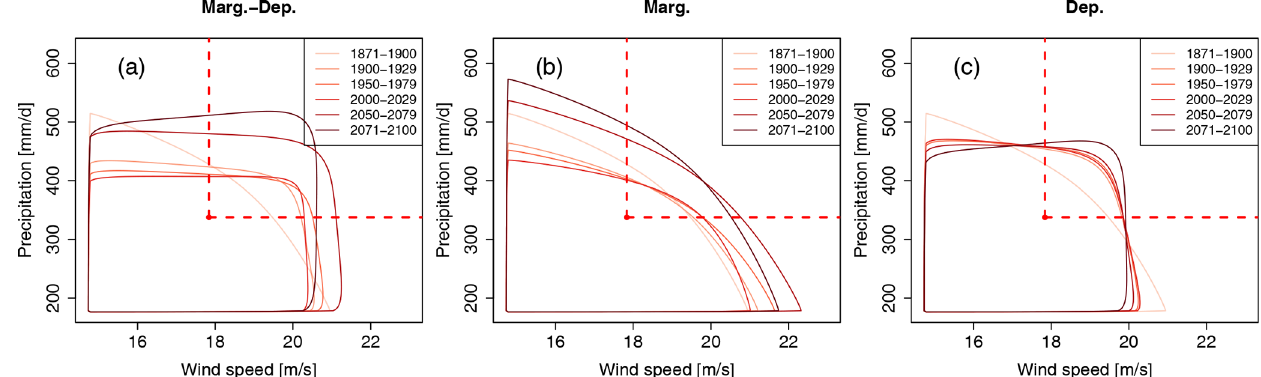
Figure 4. Change of winter (December to February) bivariate wind and precipitation extremes distributions in Brittany based on CNRM- CM6 simulations due to (a) future marginal and dependence changes (“Marg.-dep.”), (b) future marginal changes while keeping dependence properties of the reference period (“Marg.”) and (c) dependence changes while keeping marginal properties of the reference period (“Dep.”). For the bivariate distributions, contour lines encompassing 90% of all data points are shown. A selection of six 30-year sliding windows are presented using a colour gradient from light (1871–1900) to dark (2071–2100). The dashed red lines characterise the bivariate exceedance thresholds defined here as the 80th quantile of each variable.